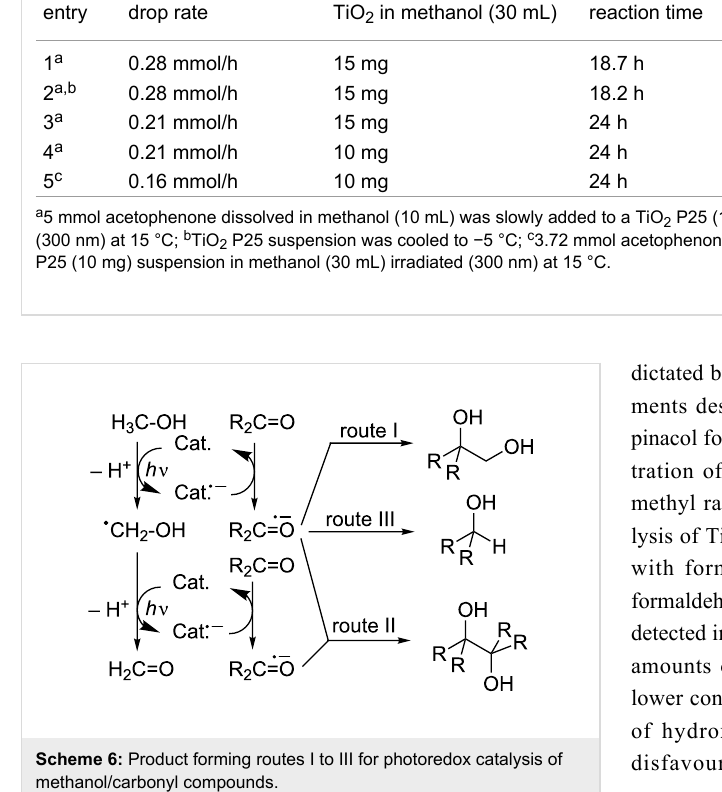
Table 5: Chemoselectivity modification by application of a dilution effect.